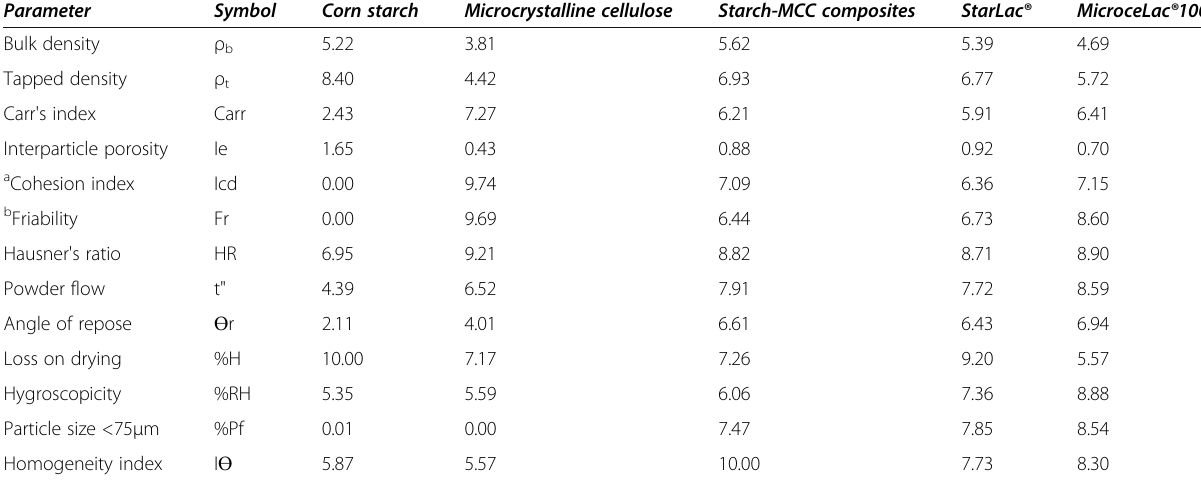
Table 2 Mean polygon radii values of the various studied parameters Parameter Symbol Corn